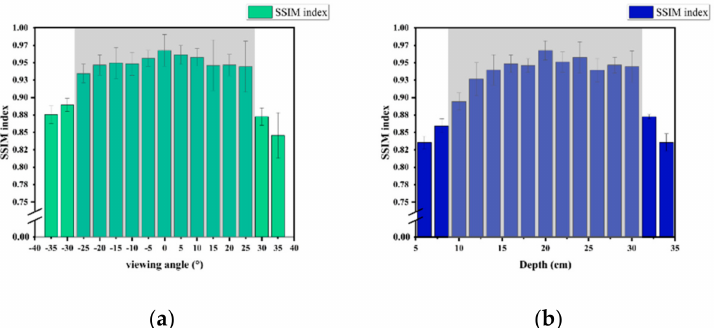
Figure 8. SSIM indices of the photograph-real result in Figure 7. ( a ) The viewing angle; ( b ) with different depth of 3D object used to generate